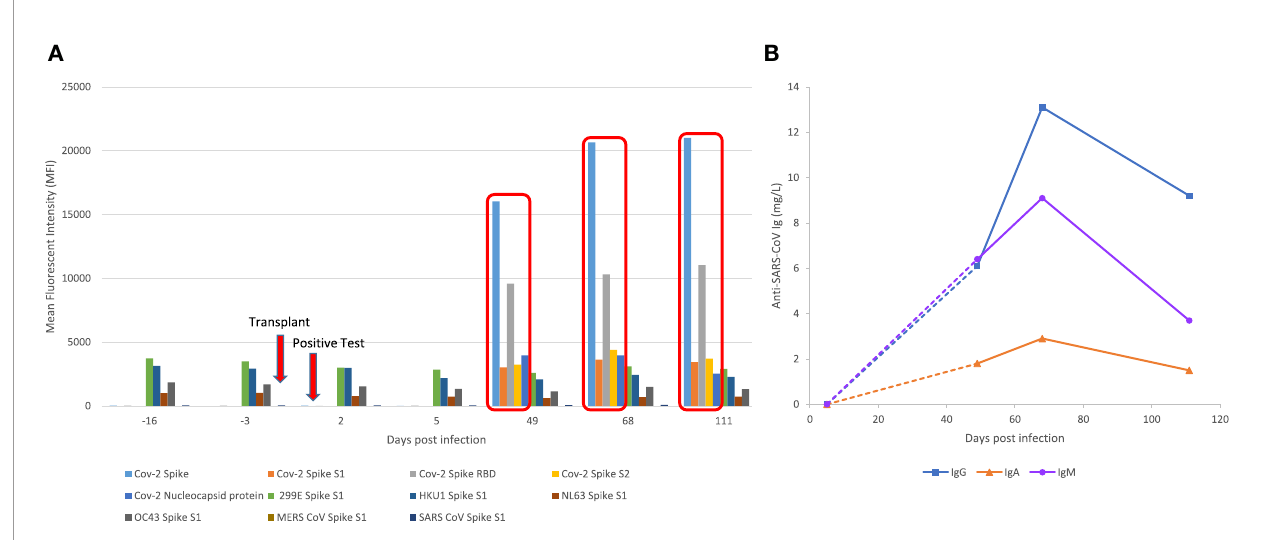
FIGURE 2 | SARS-CoV2 and non-CoV-2 antibody pro fi ling using Luminex based assays and immunoglobulin subclass assays. (A) Reactivity of serum IgG antibody to CoV-2 proteins (Full Spike, S1, S2, RBD and NC) and non-SARS-CoV-2 proteins from community coronaviruses (CoV-229E-S1, HCoV-HKU1-S1, HCoV-NL63- S1, HCoV-OC43-S1), and novel coronaviruses (MERS-S1 and SARS-S1). X-axis represents days relative to fi rst positive SARS-CoV-2 test in chronological serum dates. Y-axis represents the Mean Florescence Intensity (MFI) value of the reactivity. (B) Anti-SARS-CoV-2 IgG, IgA and IgM serum concentrations measured using the immunIQ assay